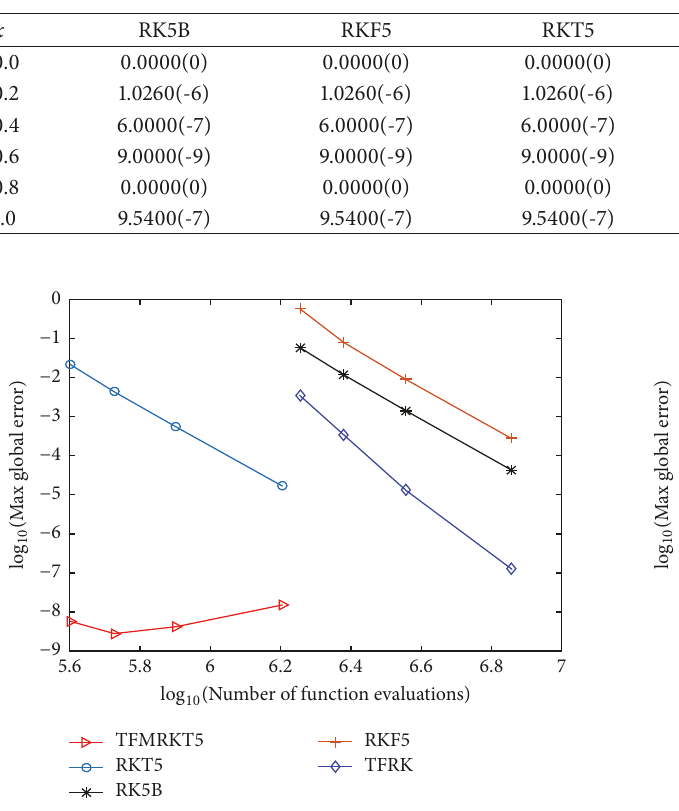
Figure 5: The efficiency curve for TFMRKT5, RKT5, RK5B, RKF5, and TFRK for Problem 6 with 𝑥 𝑒𝑛𝑑 = 10000 and ℎ = 0.025, 0.05, 0.075, 0.1 .